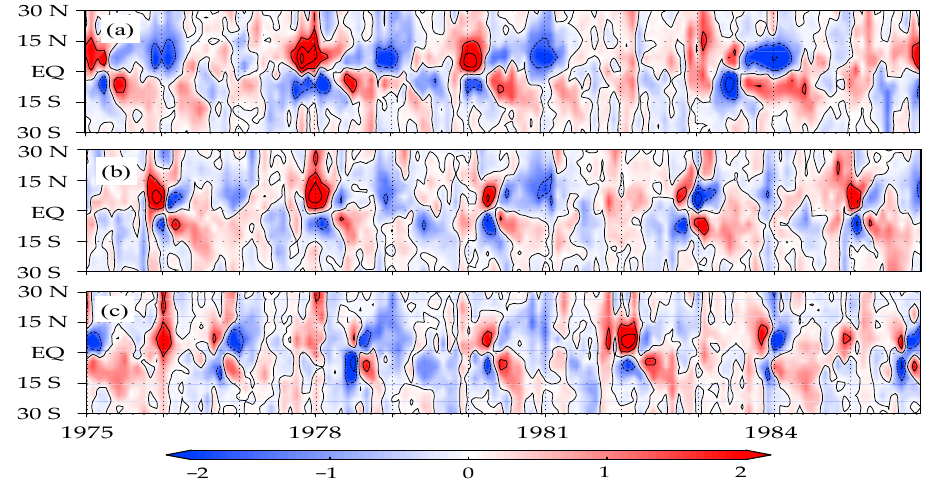
Figure 10. Time–latitude cross-sections of residual mean meridional velocity anomalies at 20 hPa for the ( a ) P, ( b ) ST, and ( c ) N runs from 1975 to 1985. Units of the color bar scale are 10 − 1 ms − 1 , and the contours interval is 1.5 × 10 − 1 ms − 1 .